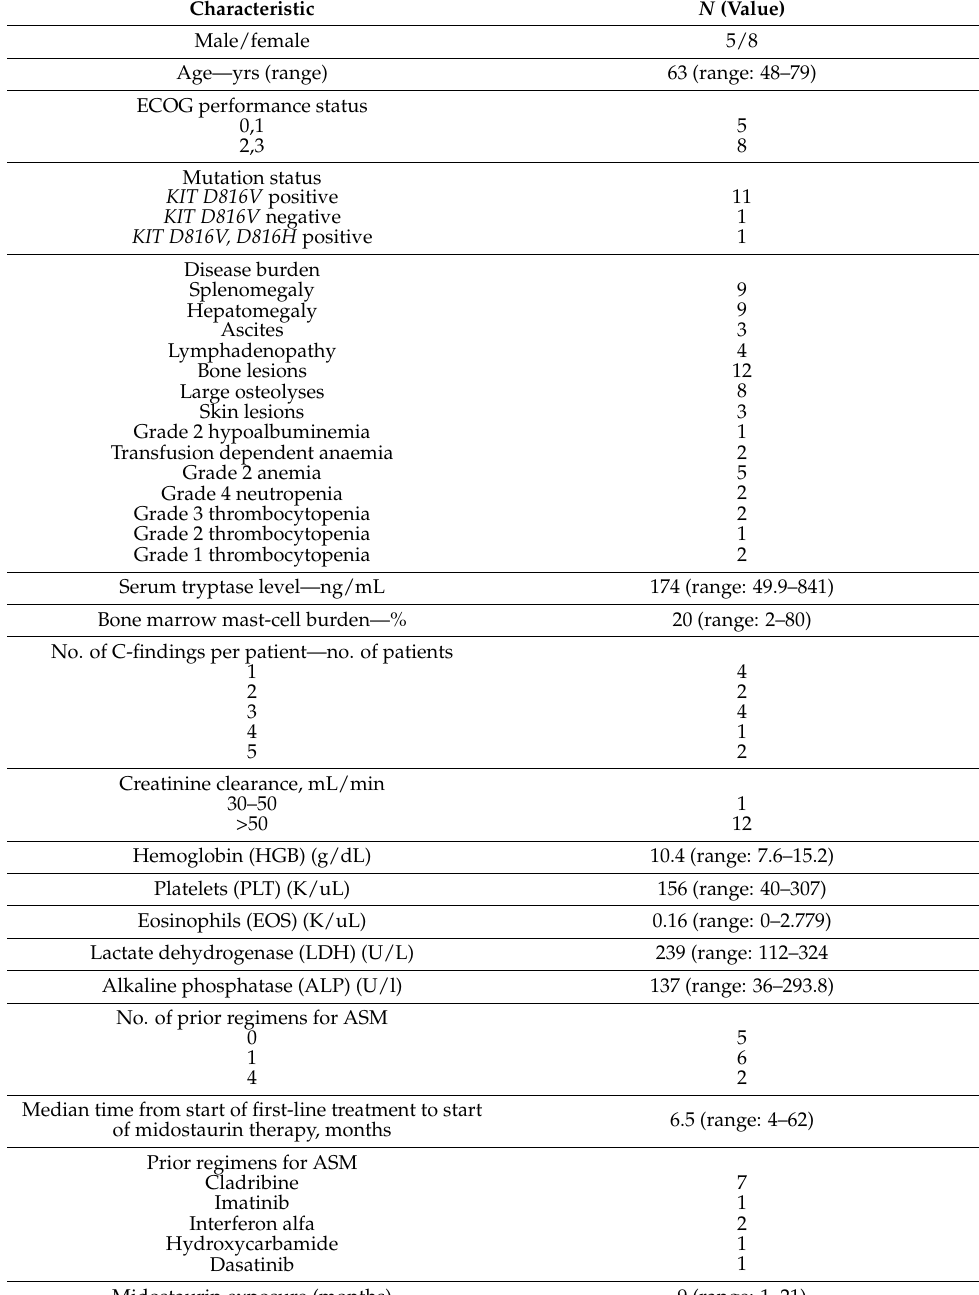
Table 1. Demographics and clinical characteristics of